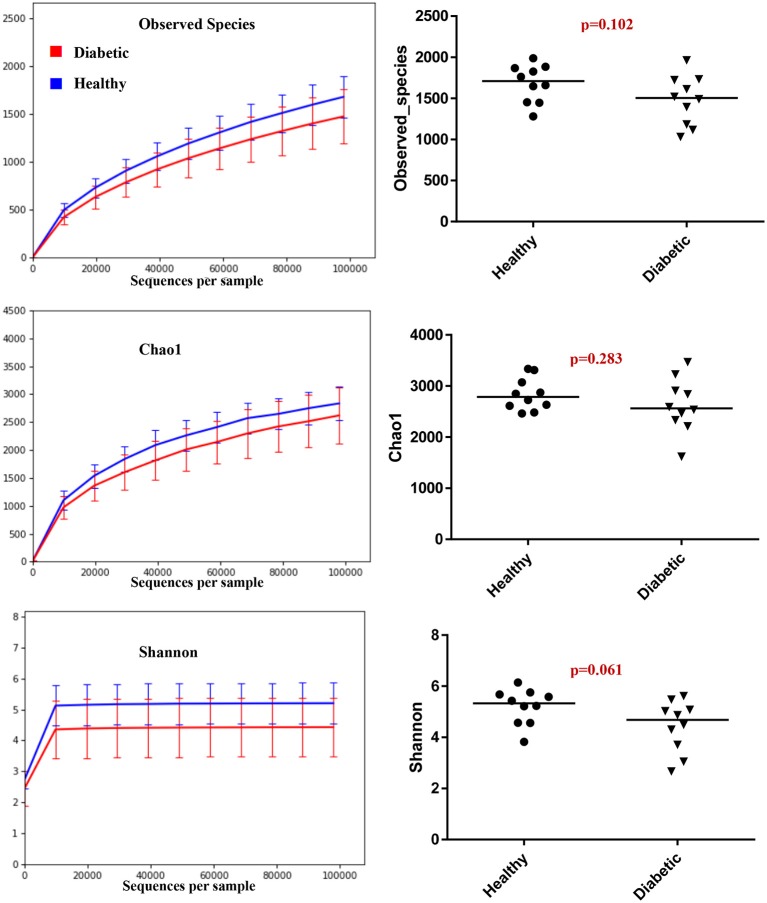
Summary of alpha diversity measures.